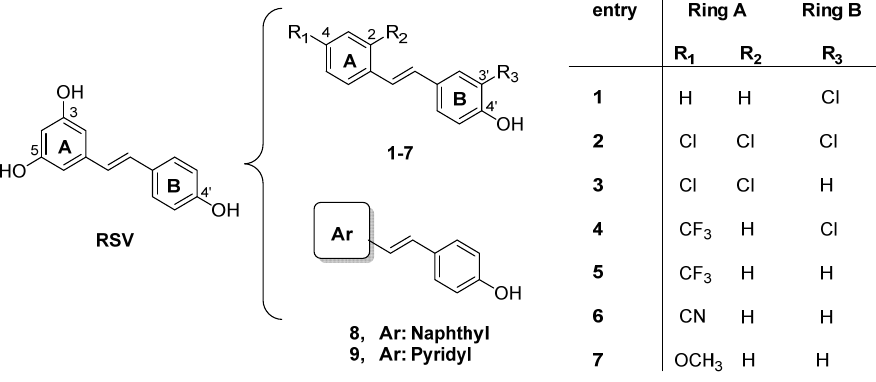
Figure 1. Resveratrol (RSV) and studied derivatives 1 – 9 .